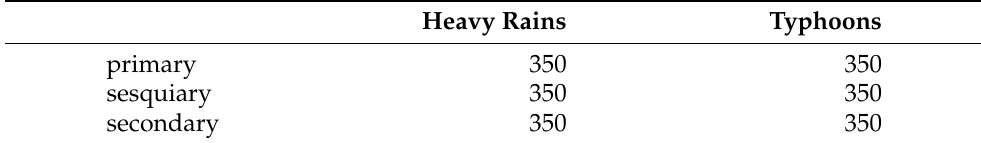
Table 8. Overview of two newest datasets from